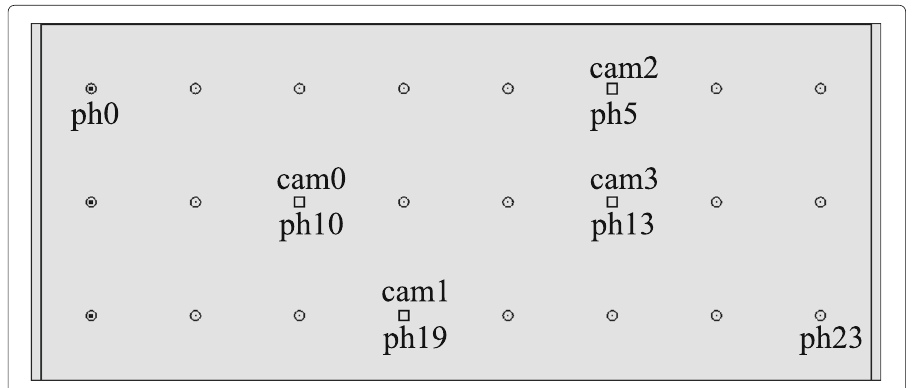
Fig. 9 Front view of the collimator (rendering). The following camera/pinhole pair layout and naming scheme is used: pair 1 (cam0/ph10), pair 2 (cam1/ph19), pair 3 (cam2/ph5), and pair 4 (cam3/ph13). The layout of the cameras is chosen such that the coverage of the target shows some